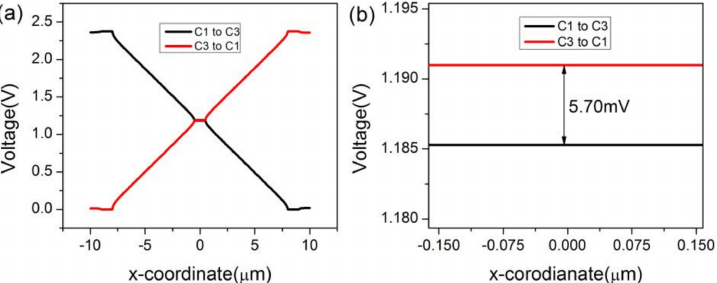
Figure 4. ( a ) Voltage along the top edge of the three-contact vertical Hall device with C2 and ( b ) distribution of voltage around C2 under different biases.